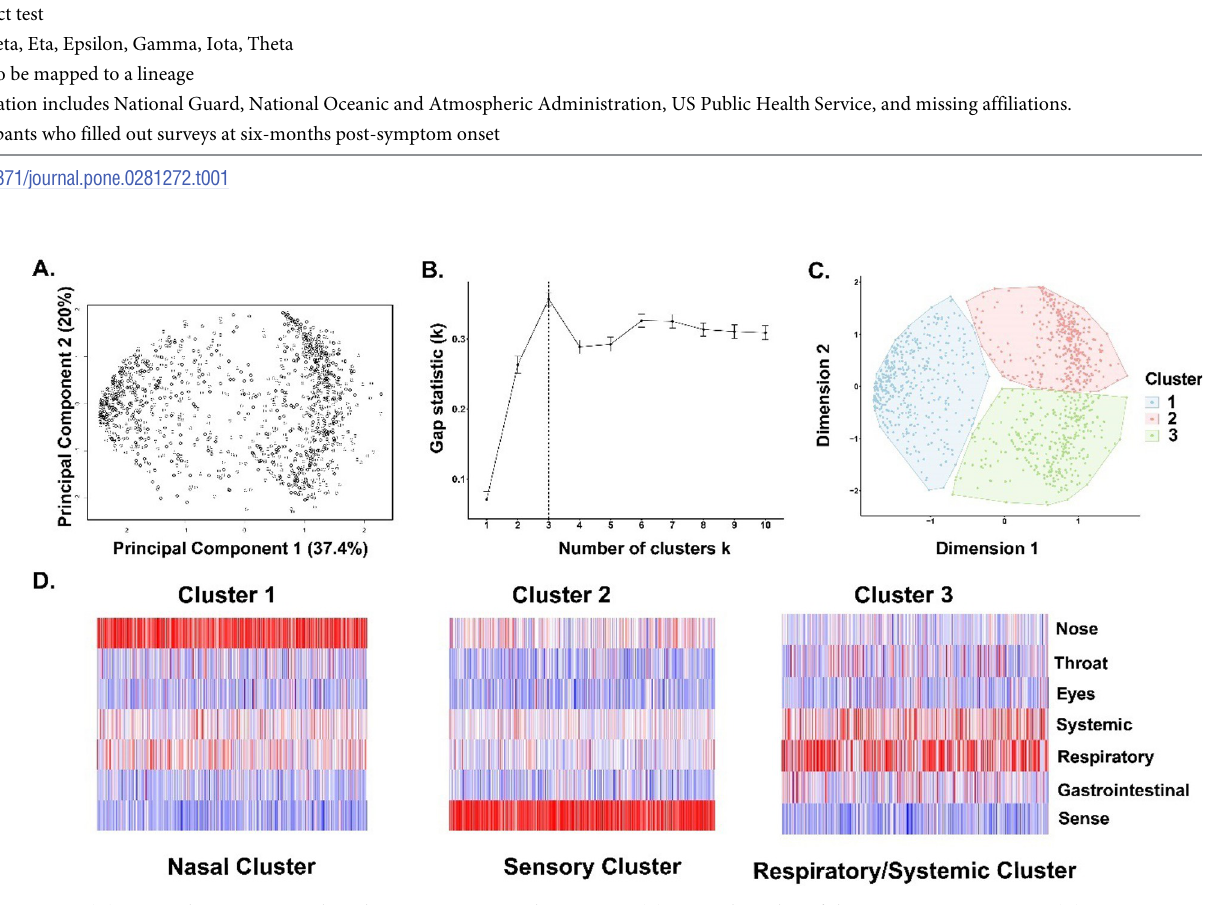
Fig 1. (A) Principal component analysis depicting FLU-PRO Plus response, (B) Optimal number of clusters using Gap-statistics, (C) K-means clustering identified three distinct clusters of participants, (D) Heatmap depicting three distinct clusters (high values are in red and low values are in